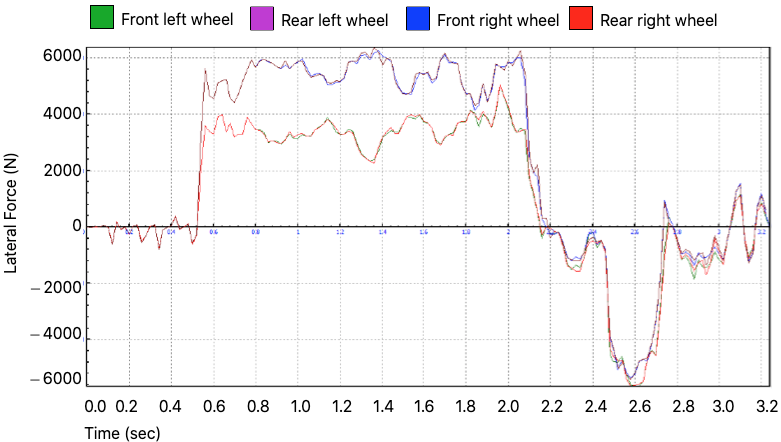
Figure 13. Total friction resistance on front bogie wheels at V = 60 km/h and V = 40 km/h .